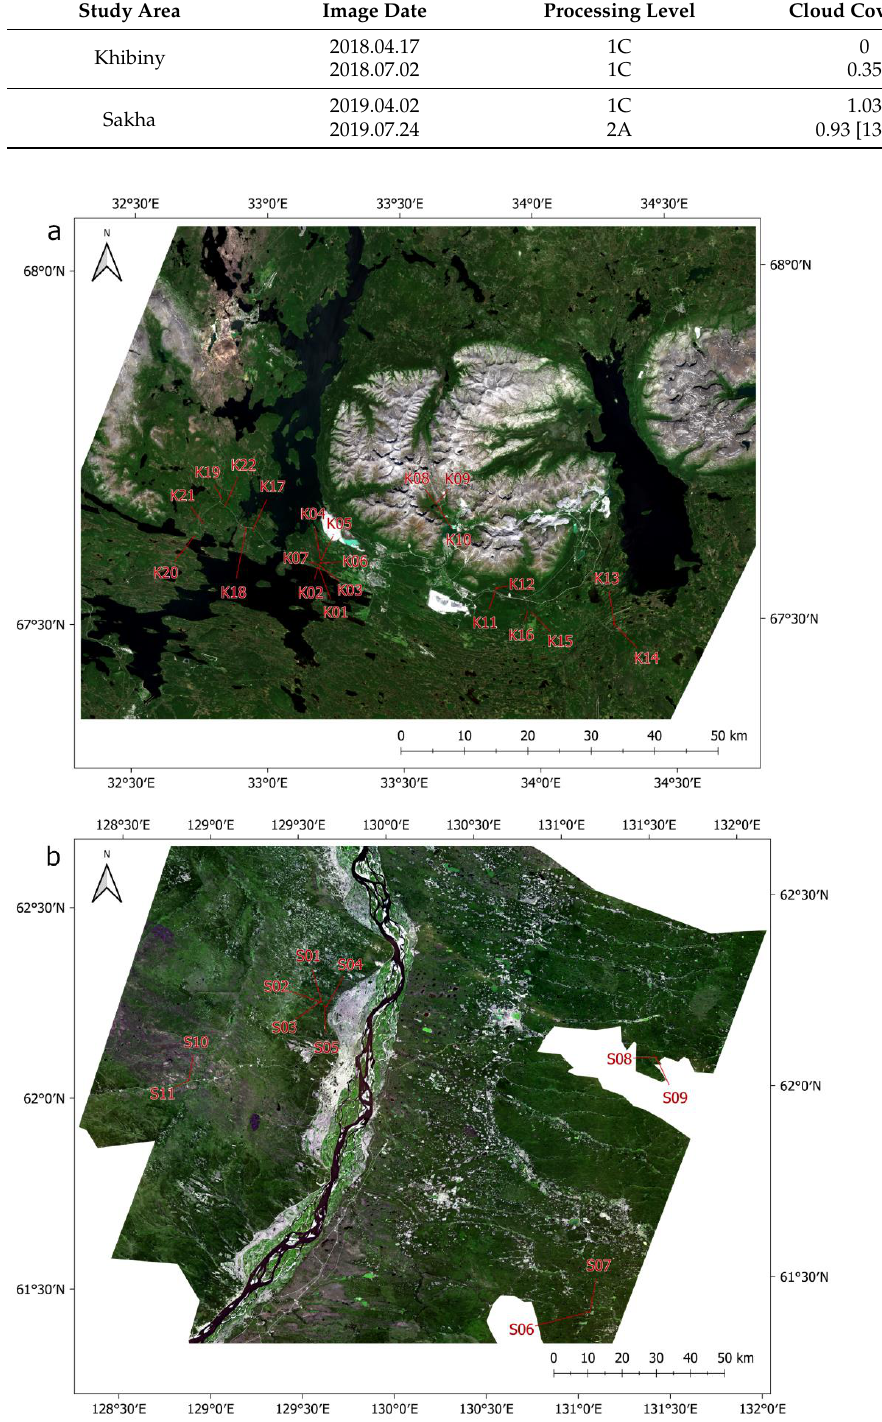
Figure 3. Location of field plots in the Khibiny ( a ) and Sakha ( b ) study areas. The backgrounds are true-colour (432) composites of the summer Sentinel-2 images identified in Table 1. Land-cover classifications were produced for the two study areas from the available MSI images using the Semi-Automatic Classification plugin (version 6.4.5: [71]) for